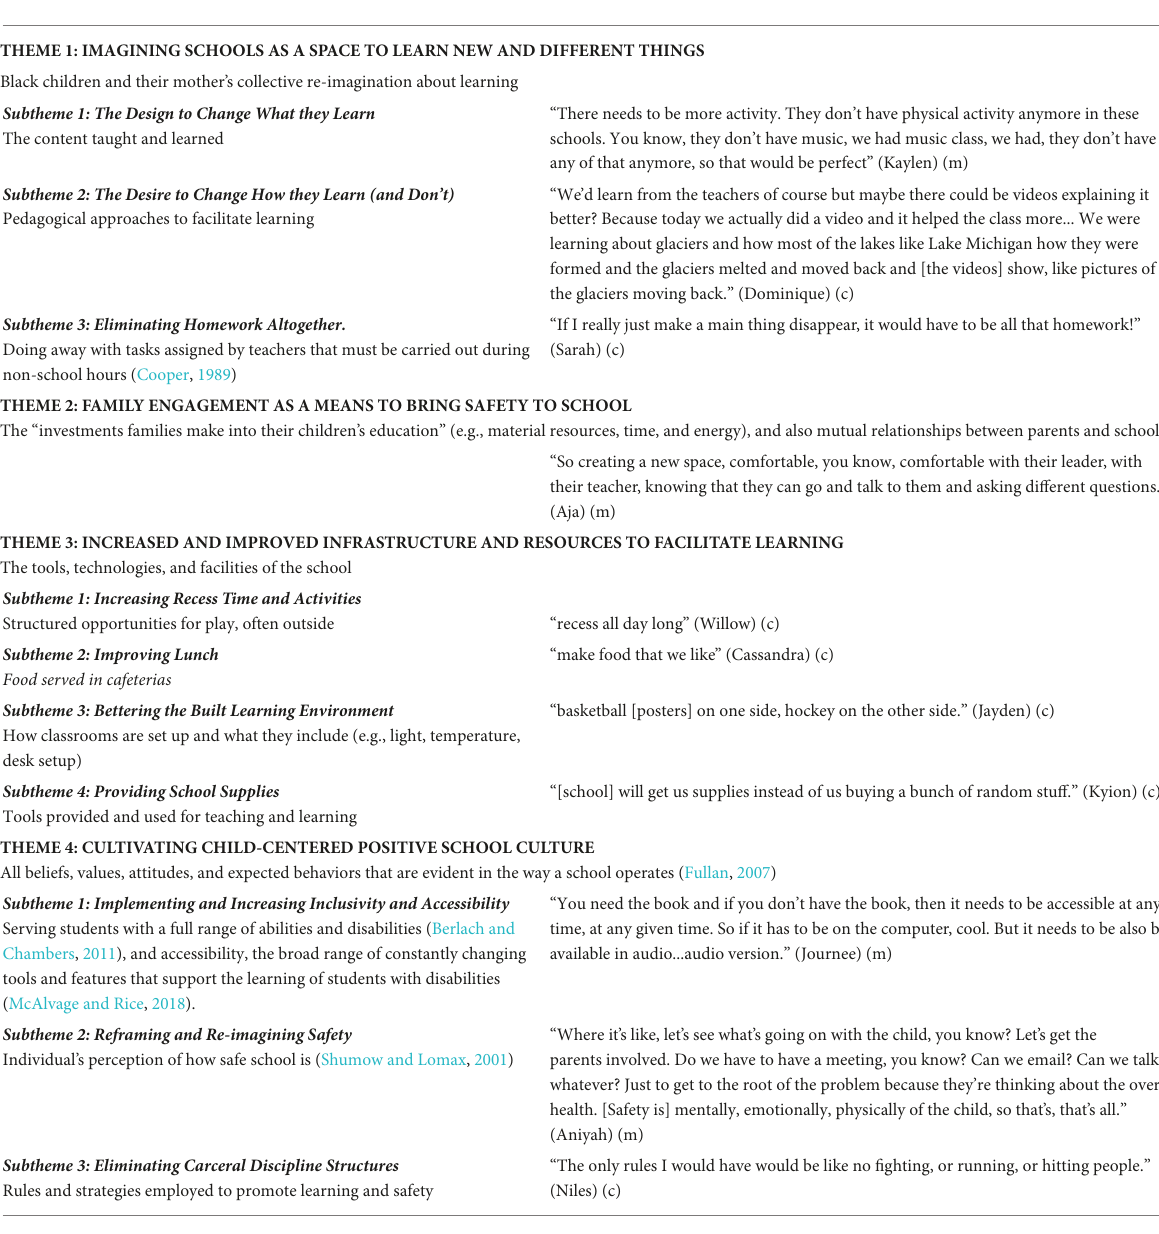
TABLE 2 Study themes, subthemes, and illustrative